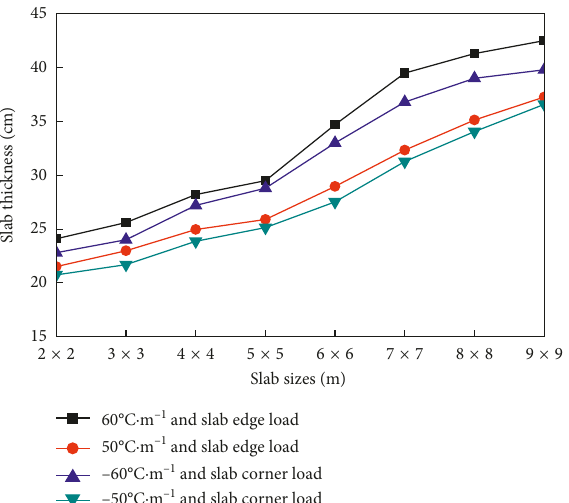
Figure 10: Critical thicknesses of concrete slabs given the combined effects of different temperature gradients and the aircraft